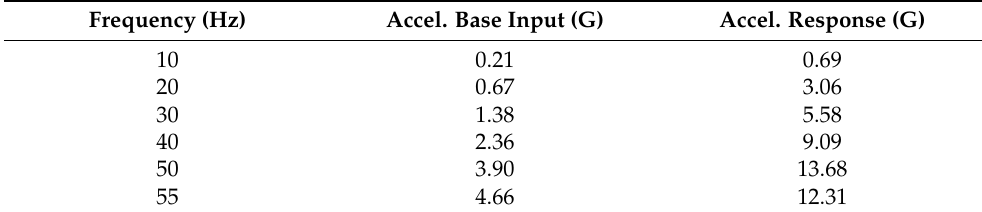
Table 3. Acceleration base input and acceleration response.